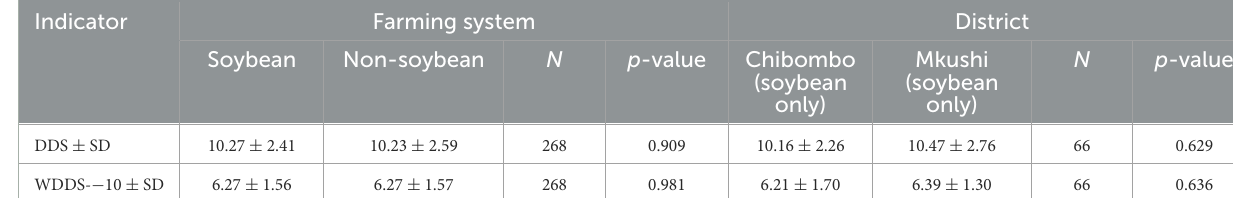
TABLE 3 Mean ± SD dietary diversity scores (DDS) and women’s dietary diversity scores (WDDS-10) categorized according to the farming system and district. Indicator